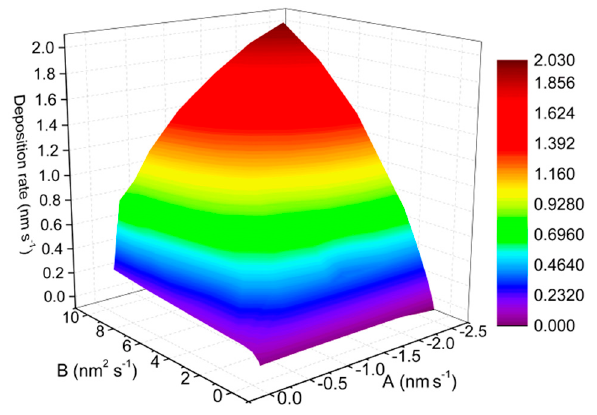
Figure 2. Calculated deposition rates based on the phase-field simulation results with different gas–solid transition velocities (i.e., B ) and incident vapor rates (i.e., A ). Here, the negative sign in front of values of A only represents the direction.